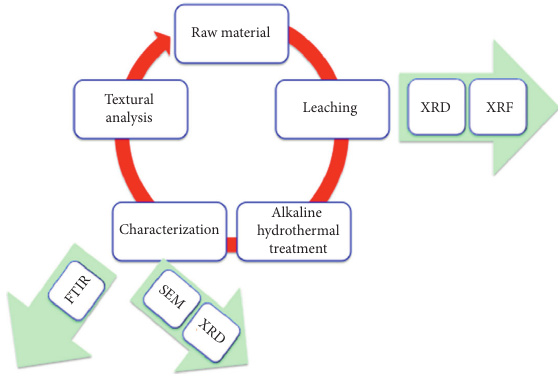
Figure 1: Flow chart for process